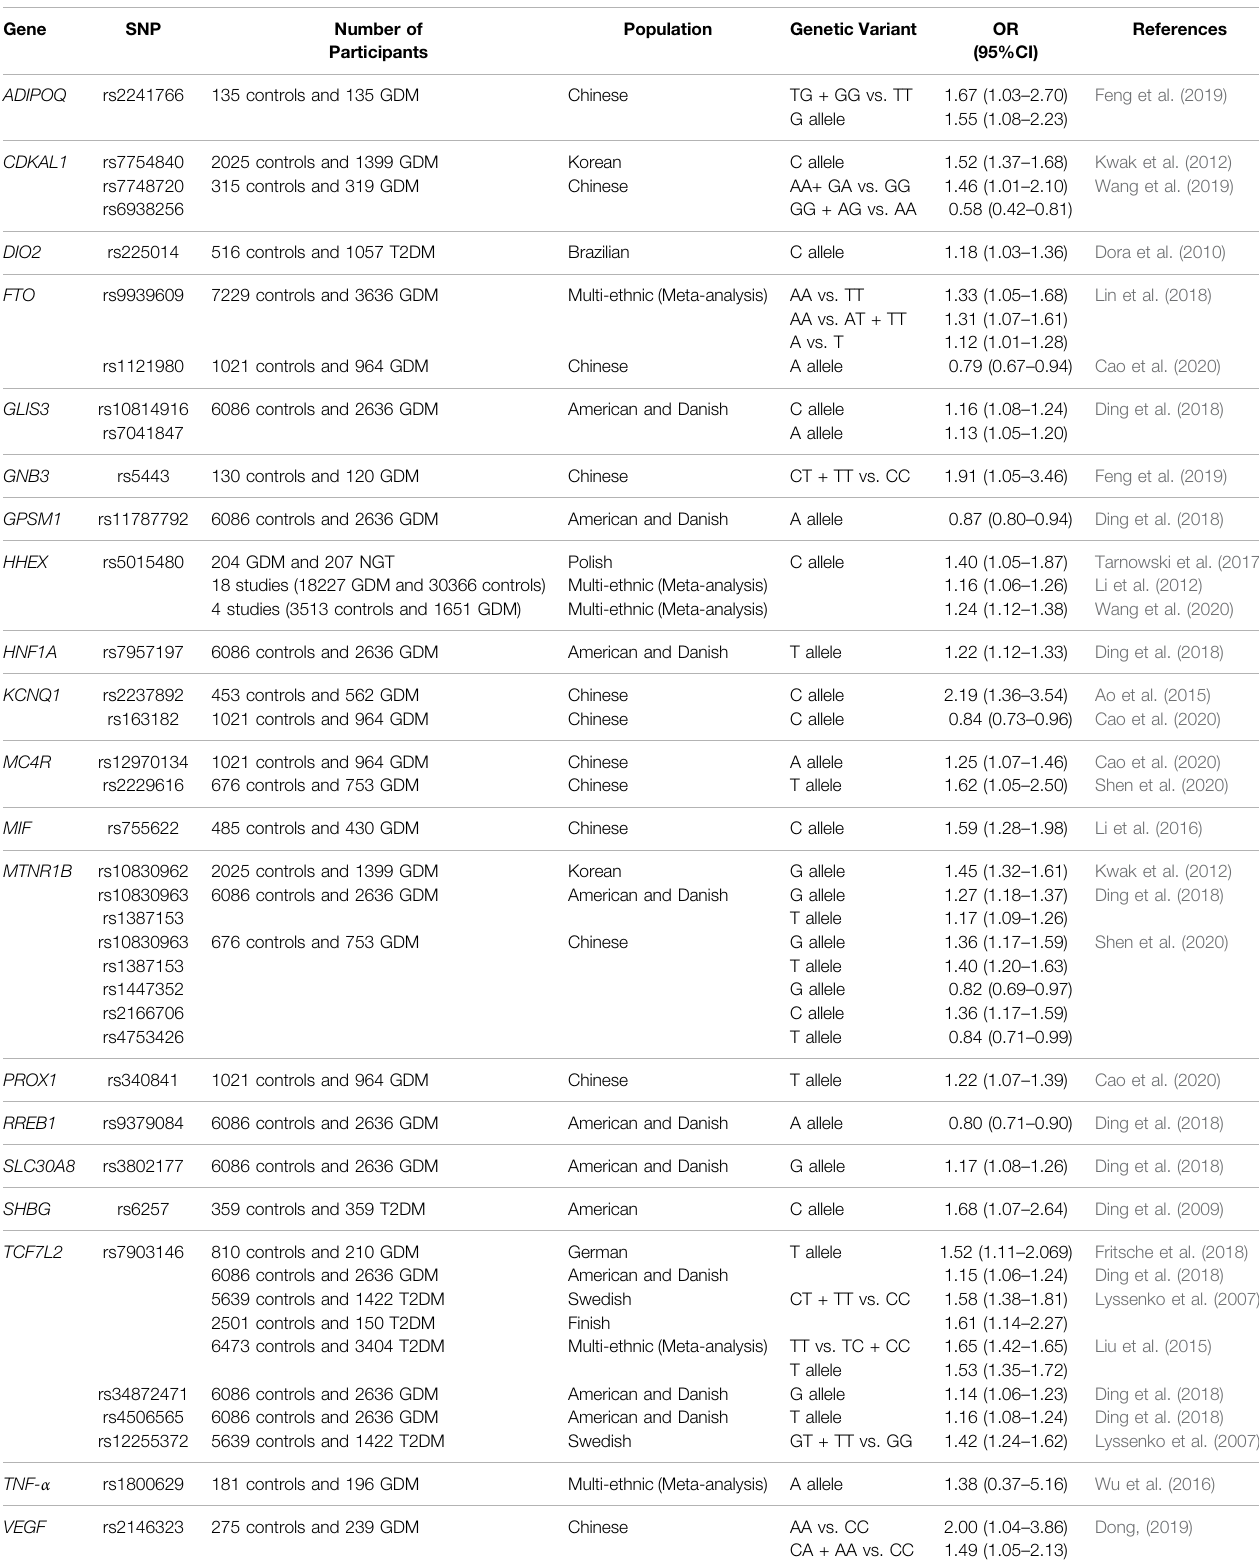
TABLE 1 | Single nucleotide polymorphisms associated with gestational diabetes